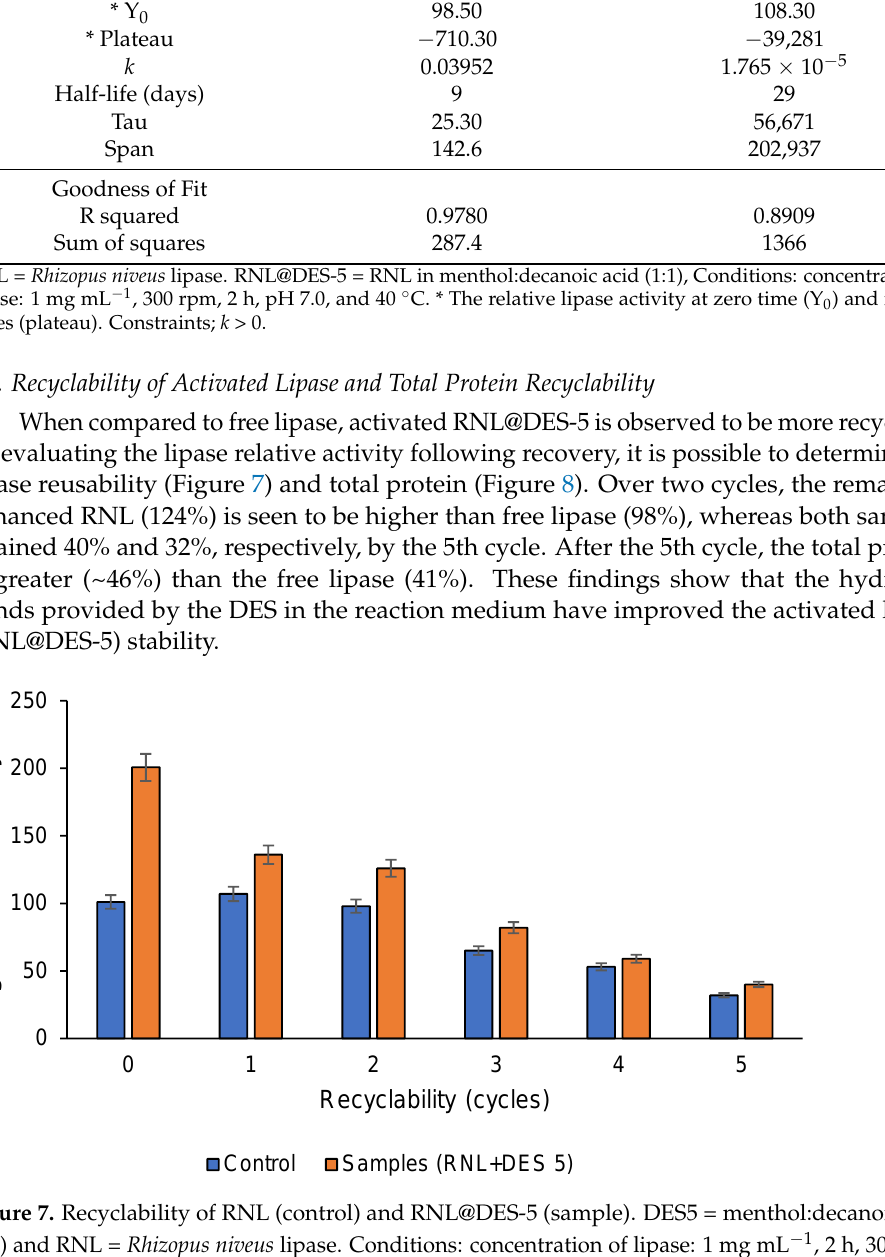
Figure 8. Total protein recyclability of RNL (control) and RNL@DES-5 (sample). DES5 = men- thol:decanoic acid (1:1) and RNL = Rhizopus niveus lipase. Conditions: concentration of lipase: 1 mg mL − 1 , 2 h, 300 rpm, 40 °C, and pH 7.0.